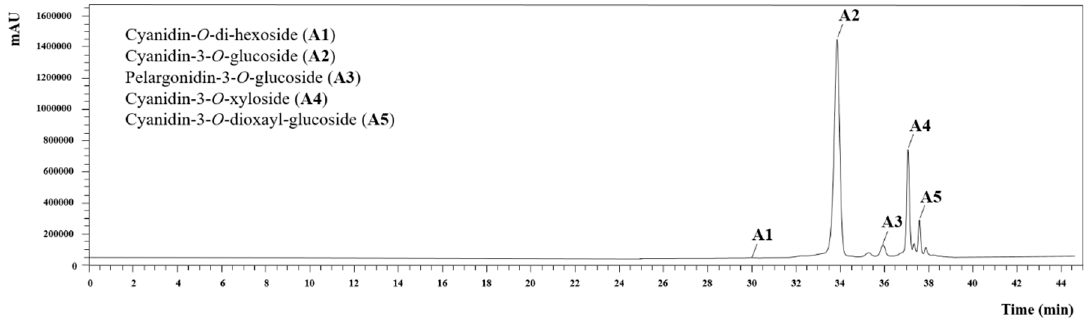
Figure 4. Example of HPLC results regarding the anthocyanin compounds found in analyzed samples.